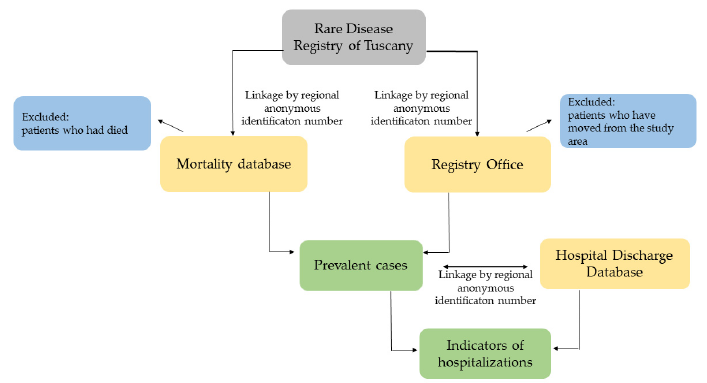
Figure 1. Flowchart of the selection